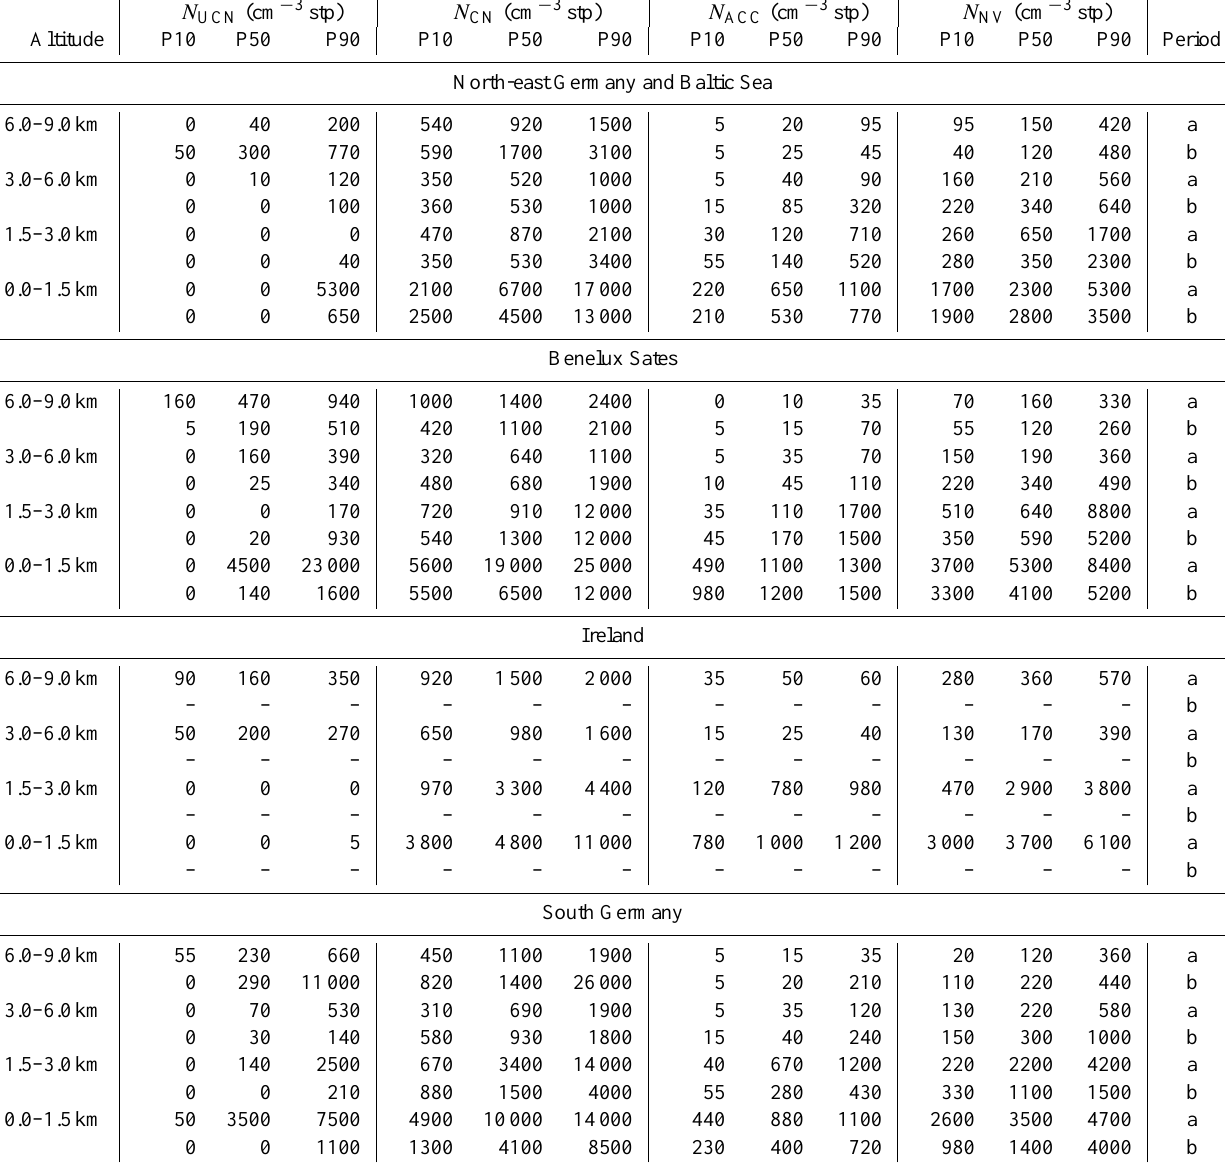
Table 2. Absolute number concentrations of UCN particles ( N UCN , 0 . 004µm < D P < 0 . 01µm), CN particles ( N CN , D P > 0 . 01µm), accu- mulation mode particles ( N ACC , D P > 0 . 15µm), and non-volatile particles ( N NV , D P > 0 . 014µm, 250 ◦ C) in cm − 3 stp. All concentrations are given at standard pressure and temperature. The 10th (P10), 50th (P50, i.e. median), and 90th (P90) percentile are given for each vertical bin above the respective region for each